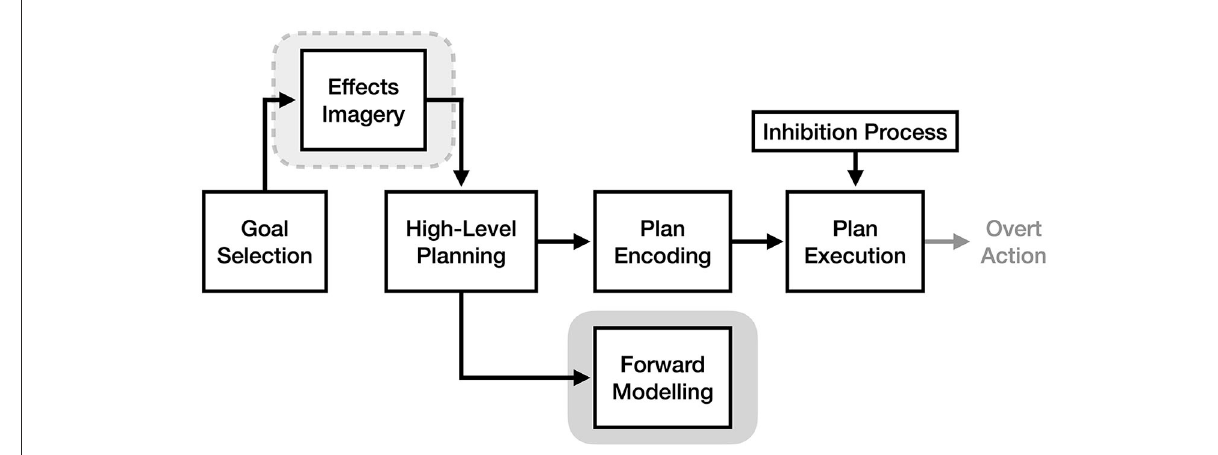
FIGURE6 The process of motor imagery as proposed by the effects imagery model. The stage of motor execution thought to be responsible for the experience of effects imagery is enclosed in light gray. The stage responsible for traditional motor imagery is enclosed in dark